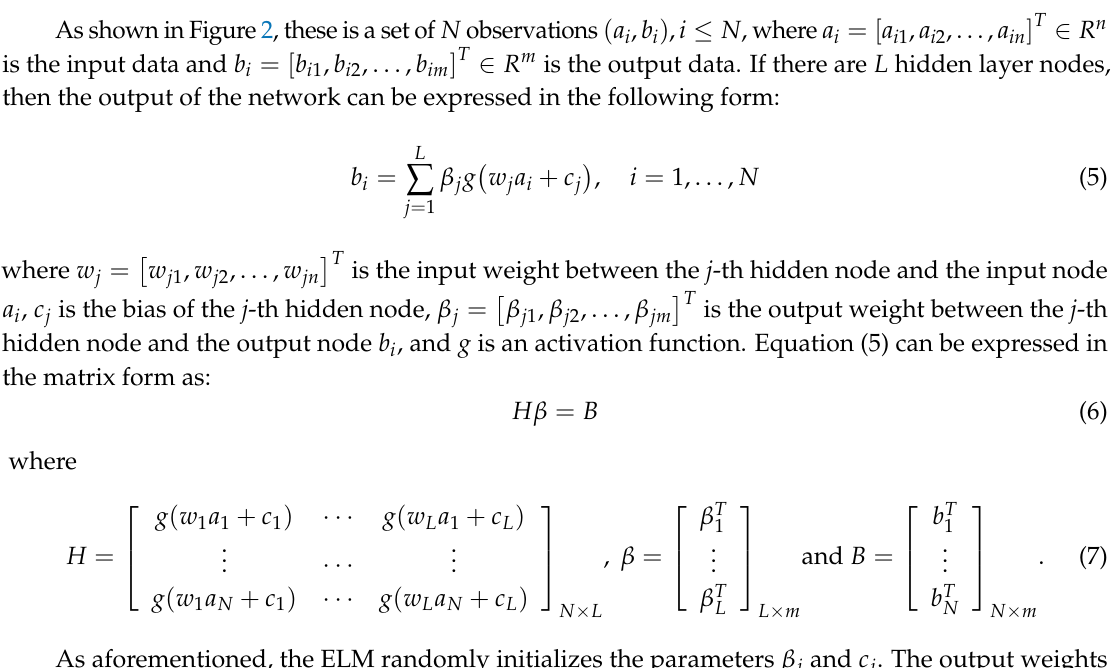
Figure 2. The schematic diagram of extreme learning machine